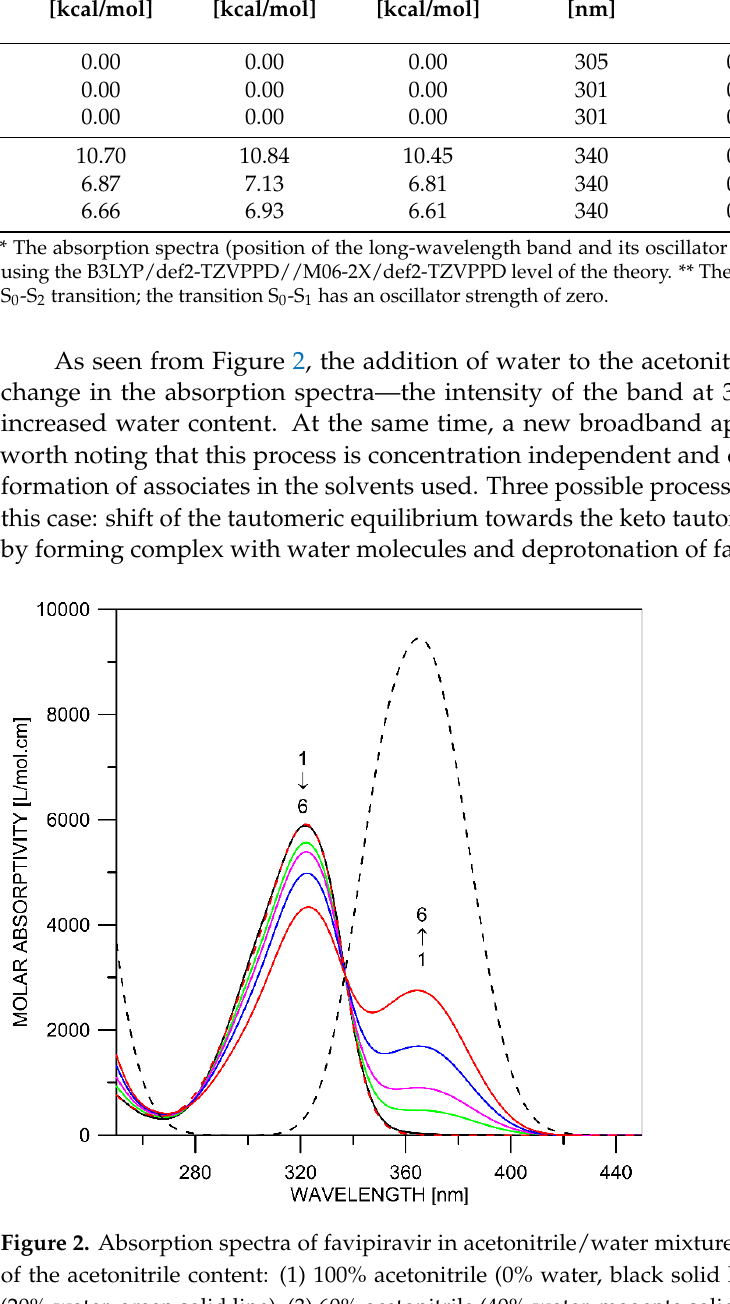
Figure 3. Simulated absorption spectra (B3LYP/def2-TZVPPD//M06-2X/def2-TZVPPD) in acetoni- trile: 1E (black solid line), 1K (black dashes), 1E ’’ (red dashes) and the most stable (Supplementary Table S3) deprotonated form (red solid line). According to the theoretical simulations, the obtainment of 1E ’’ should be accompa- nied by a blue shift in the spectra, which is not observed. The existence of the OH group in the enol forms gives a possibility for partial deprotonation with the addition of water. The deprotonation in acetonitrile with the addition of triethyl amine also leads to a red shift in the absorption, with appearance of a new band at 371 nm (Supplementary Figure S2 and